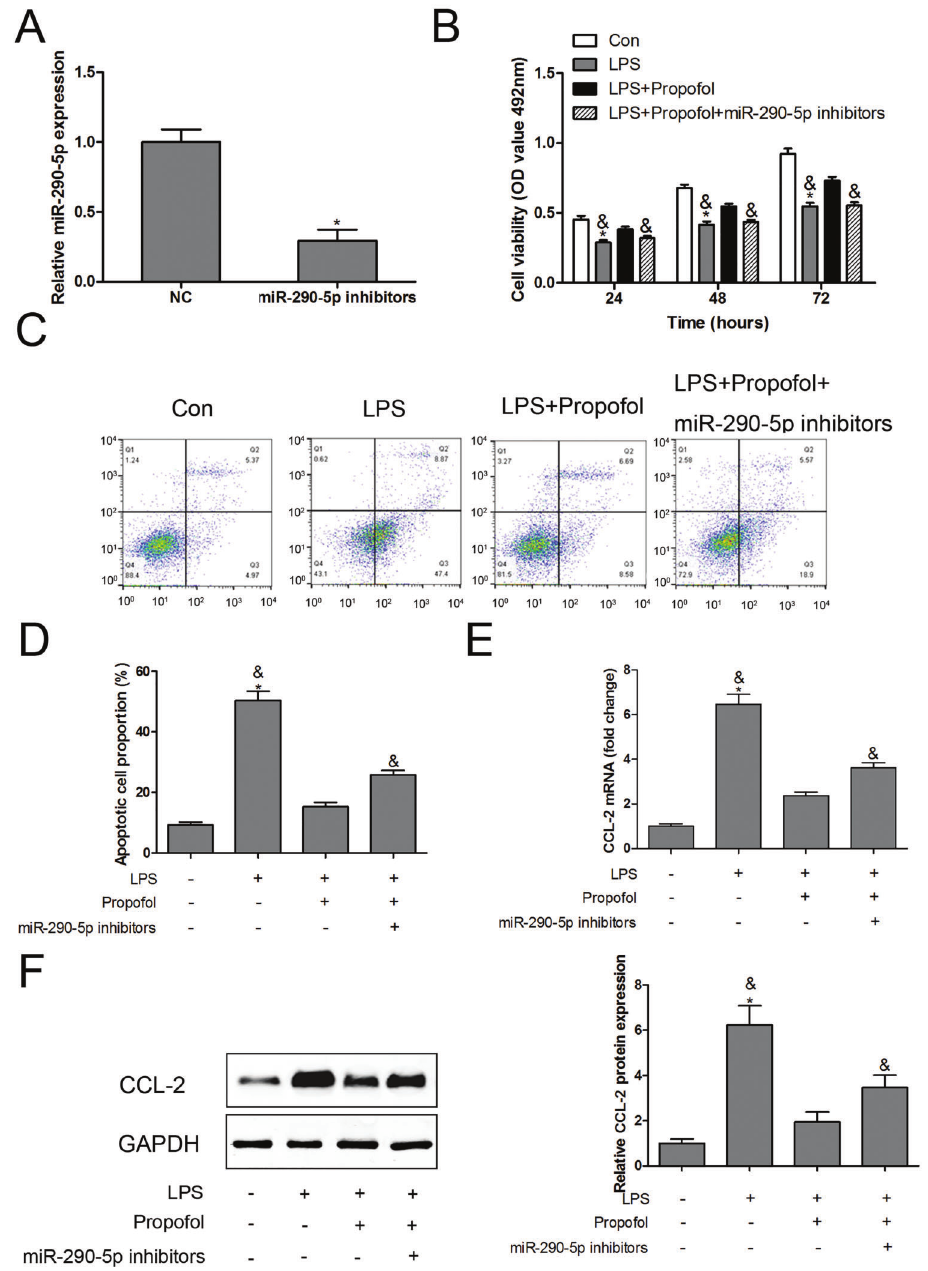
Figure 6. Inhibition of miR-290-5p neutralized the protective effect of propofol in lipopolysaccharide (LPS)-treated mouse podocytes (MPC5). The levels of miR-290-5p were measured by RT-qPCR after being transfected with miR-290-5p inhibitors in MPC5 ( A ). In LPS- treated MPC5 combined with propofol or propofol + miR-290-5p inhibitors, cell viability was measured using the MTS assay ( B ); apoptosis was analyzed using fl ow cytometry ( C and D ); the mRNA ( E ) and protein ( F ) expression of CCL-2 were detected by RT-qPCR and western blotting, respectively. Data are reported as the means ± SD (n=3 in each group). *P o 0.05 compared with control group; & P o 0.05 compared with LPS + propofol